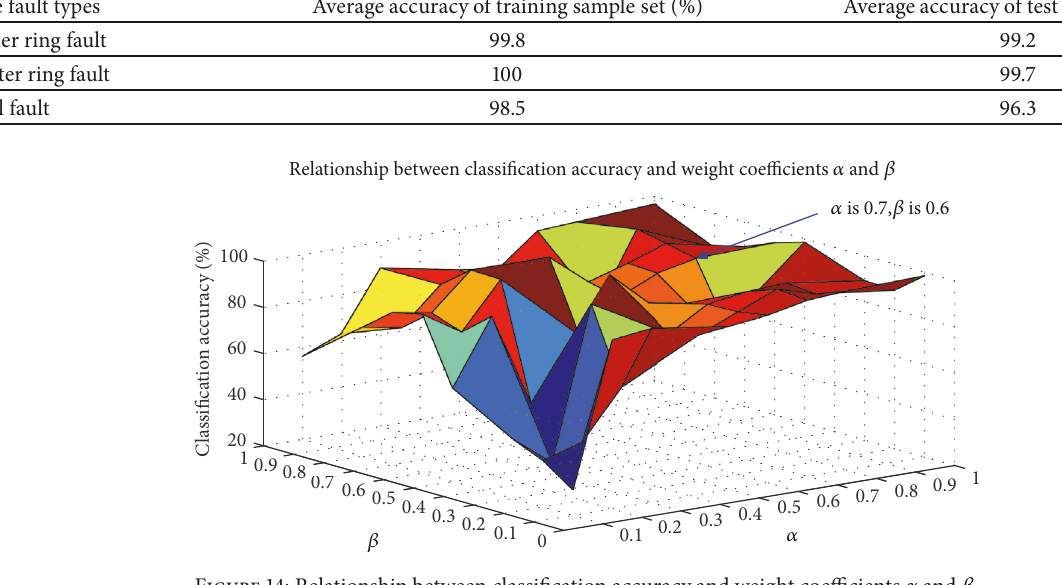
Figure 14: Relationship between classification accuracy and weight coefficients 𝛼 and 𝛽